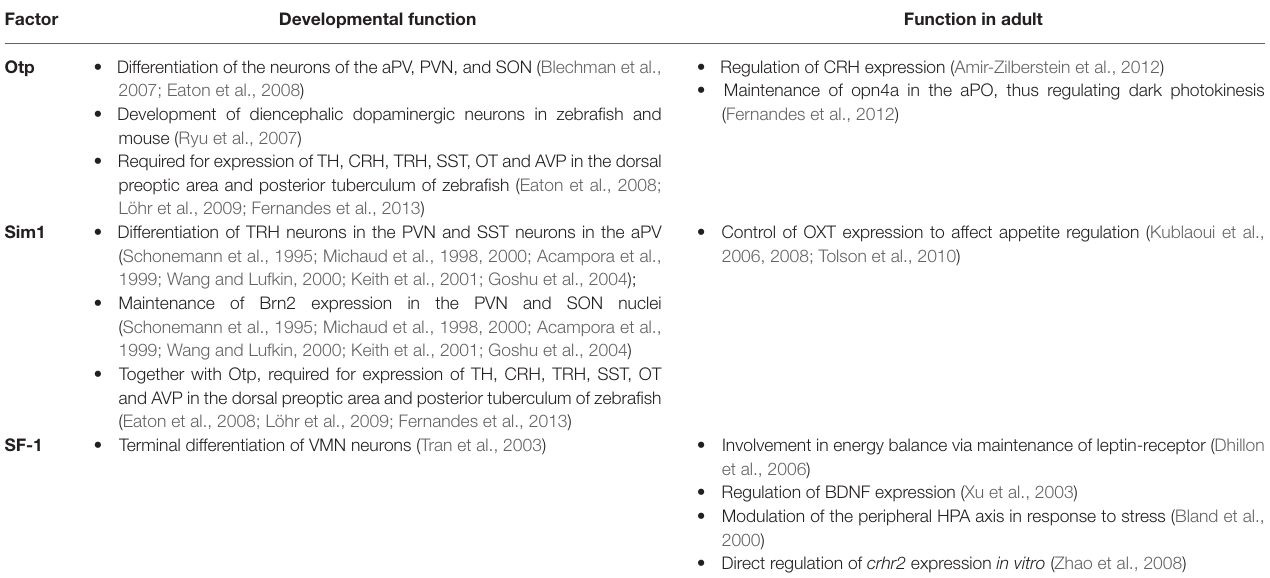
TABLE 1 | Key functions demonstrated for transcription factors expressed in both developing and mature hypothalamus. Factor Developmental function Function in